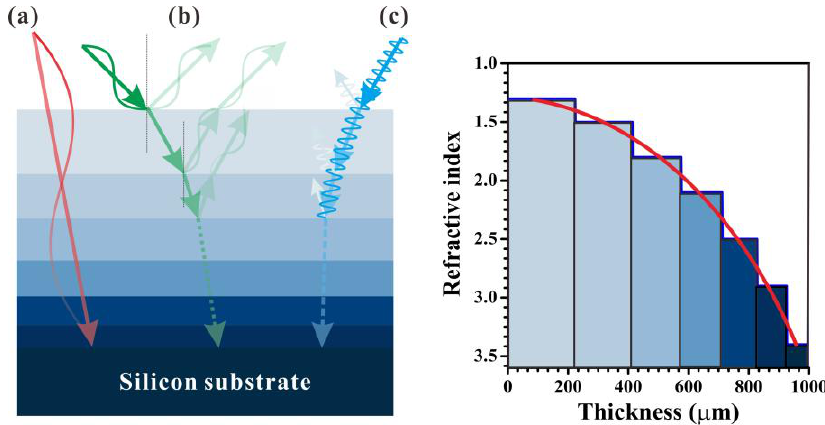
Figure 5. ( Left ) Schematic diagram of the ultra-broadband antireflection (AR) coating. The bottom substrate is a Si wafer, and the refractive indices were changed gradually with a flat six-layer structure. The red (a), green (b), and blue (c) lines stand for the propagated behaviors of different wavelengths in the terahertz range. ( Right ) Refractive index profile of the six-layer structure as a function of the thickness of each layer.